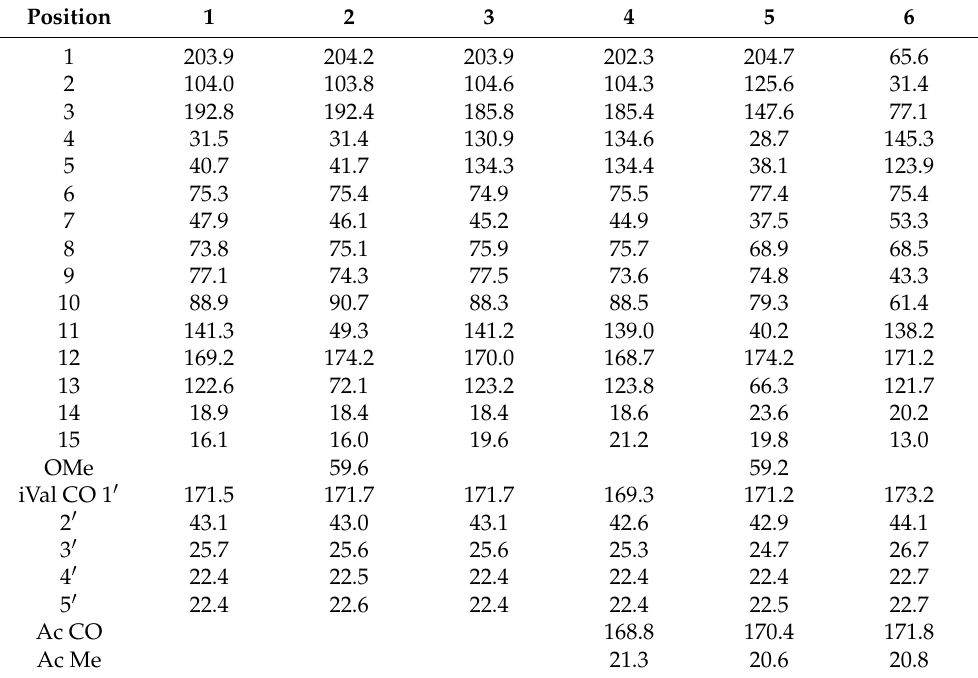
Table 2. 13 C NMR data of compounds 1 – 6 in CDCl 3 at 125 MHz ( δ C in